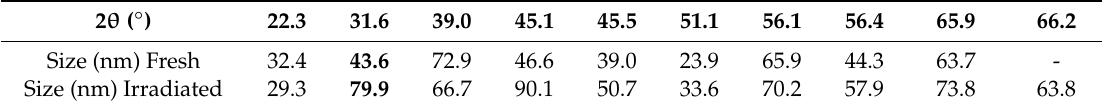
Table 4. BaTiO 3 crystallite size at various reflections before and after microwave irradiation at 1800